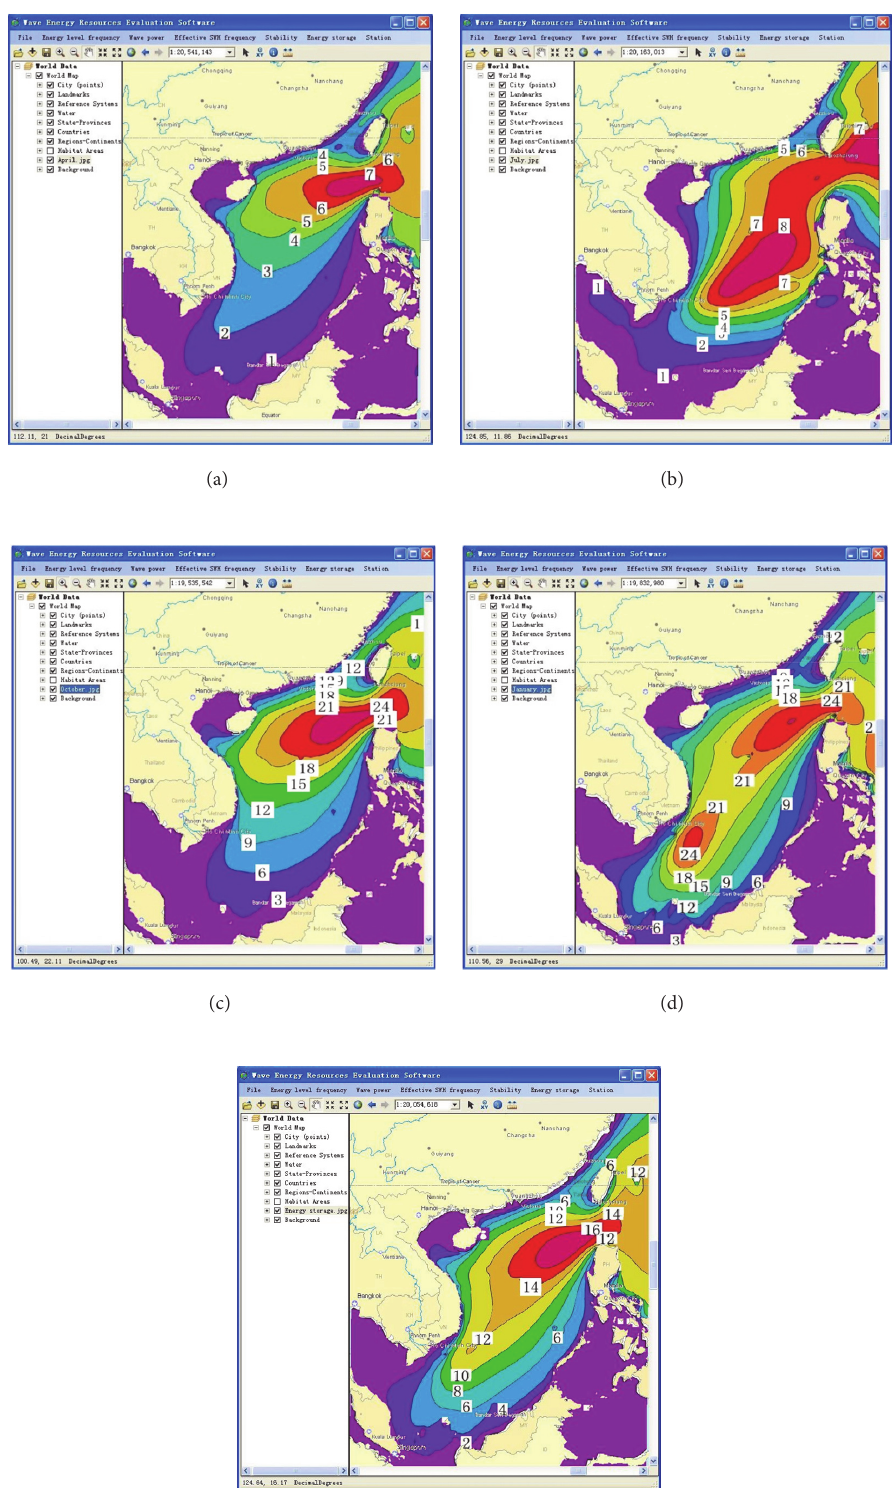
Figure 4: The seasonal and annual average wave power densities in the South China Sea. (a) Spring, (b) summer, (c) autumn, (d) winter, and (e) annual average. Unit: